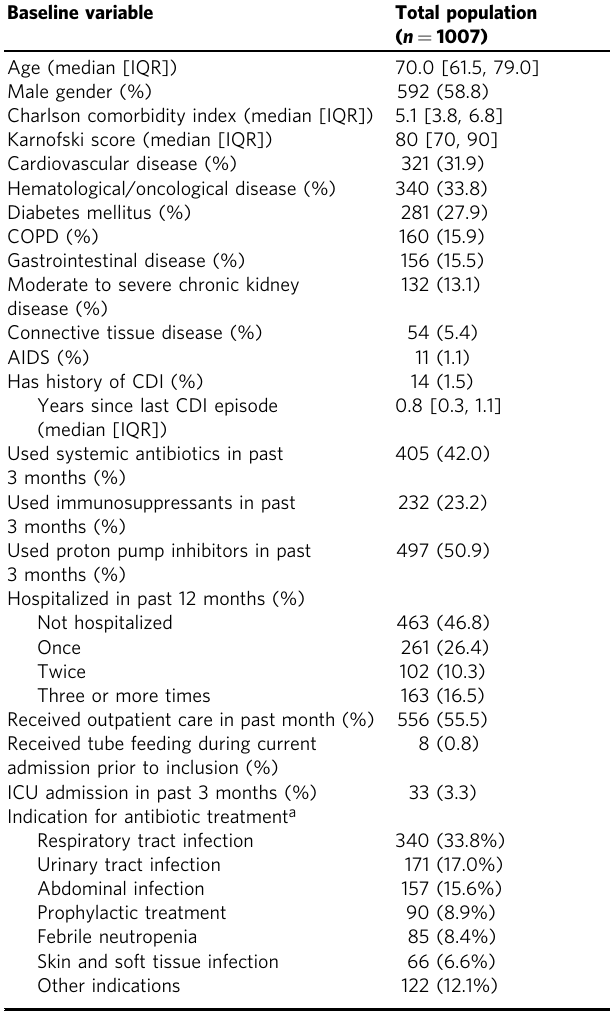
Table 1 Baseline